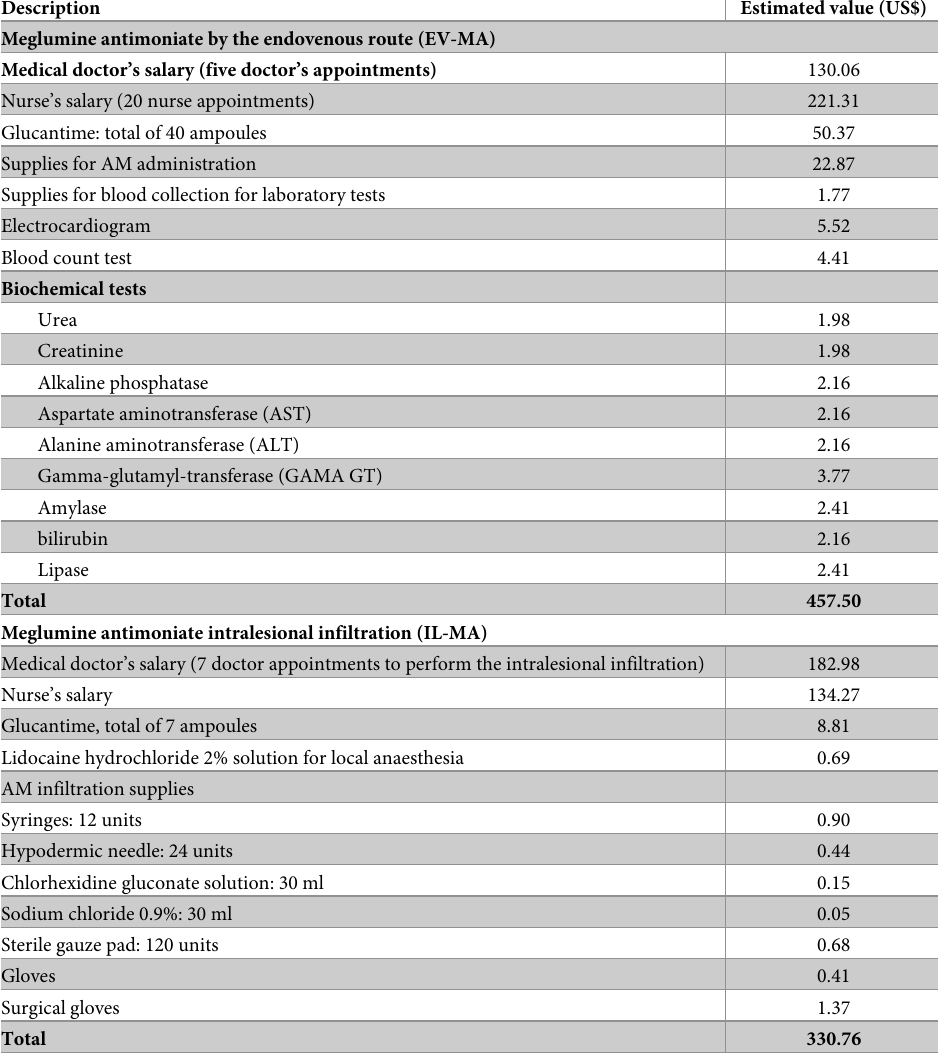
Table 1. The costs related to meglumine antimoniate intralesional infiltration and to endovenous meglumine antimoniate treatment.